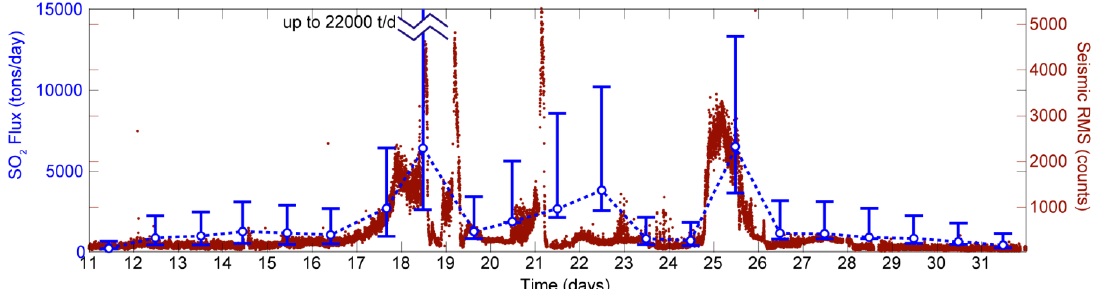
Figure 8. SO 2 fluxes measured from 11 May 2016 to 31 May 2016 encompassed the 16–25 May eruptive period (blue bars show the maximum and minimum values while white dot indicates the daily average), which show a good agreement with seismic tremor amplitude, with relative maxima fitting the phases of enhanced seismic activity linked with paroxysmal events during the eruptive